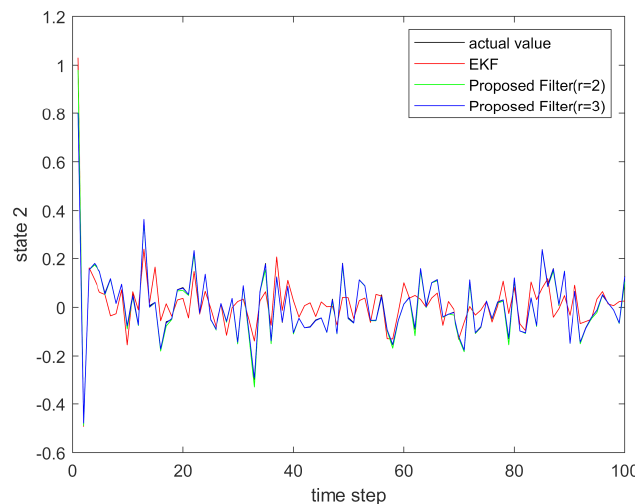
Figure 6. The actual value of state 2 and its estimation.